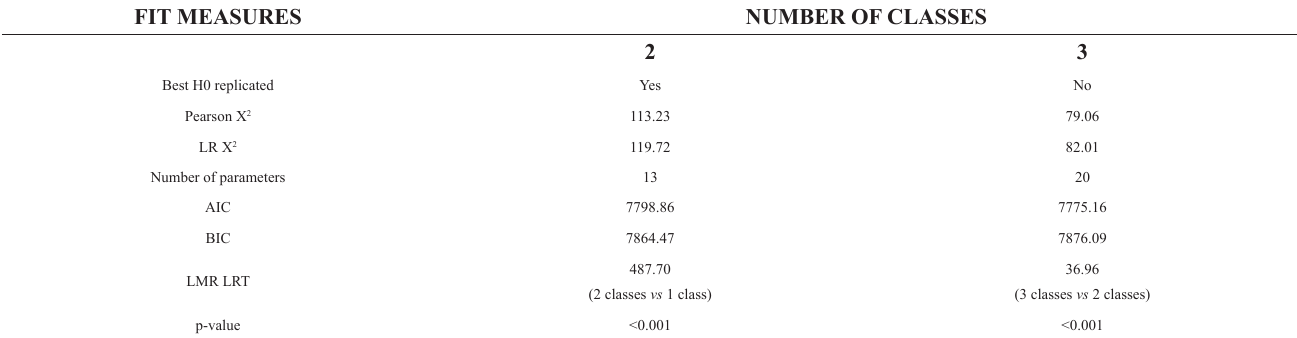
Table 2 - Criteria used to identify the best number of latent classes